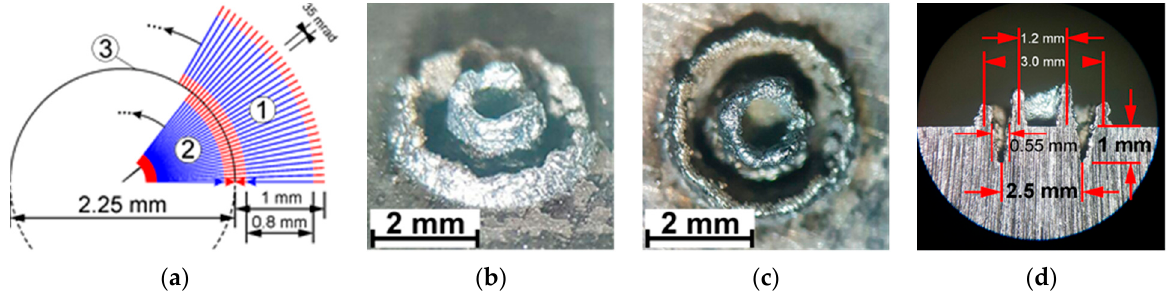
Figure 9. ( a ) Graph of the dependences of the groove depth ( D ) on the number of passes ( N ), with different distances between the vectors ( R ), as well as ( b ) the transverse sections of the grooves obtained.